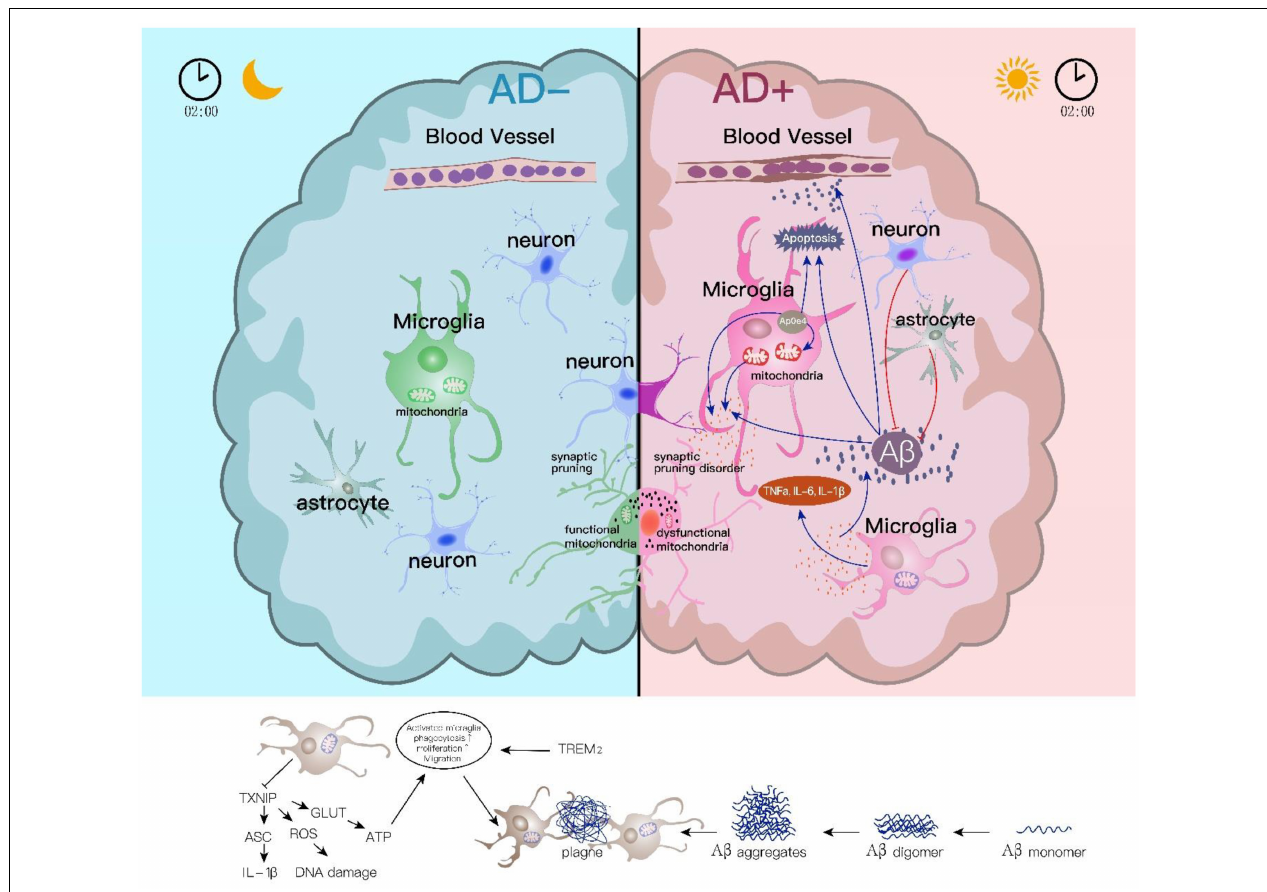
FIGURE 1 | Astrocyte and microglial roles in sleep disturbance linked Alzheimer’s disease. Sleep and CNS immune influence each other. Microglial responses in the sleep/wake are essential for A β clearance and inflammatory activation. A β accumulation induces abnormal mitochondrial function in microglia which further activates the release of inflammatory cytokines, while A β clearance by microglia phagocytosis relies on the stimulation of A β itself. TREM2 in the microglia membrane combines with A β and then enhances its ability on A β phagocytosis. The downregulated TXNIP induces ROS inhibition and further causes DNA damage during sleep disorders. On the contrary, lower TXNIP under sleep disturbances could increase NLRP3 inflammasome activation and IL-1 β -initiated inflammatory response. Apart from the role in A β clearance and A β involved inflammation, microglia directly participate in synapse removal or “synaptic stripping,” and this is regulated by normal sleep/wake